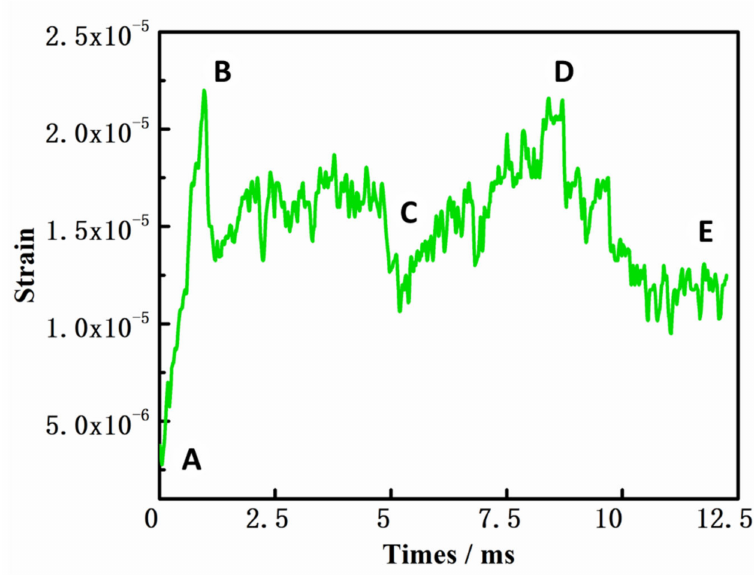
Figure 11. Results of the composite puncture experiment (The curves marked A to E in the figure represent different stages in the puncture